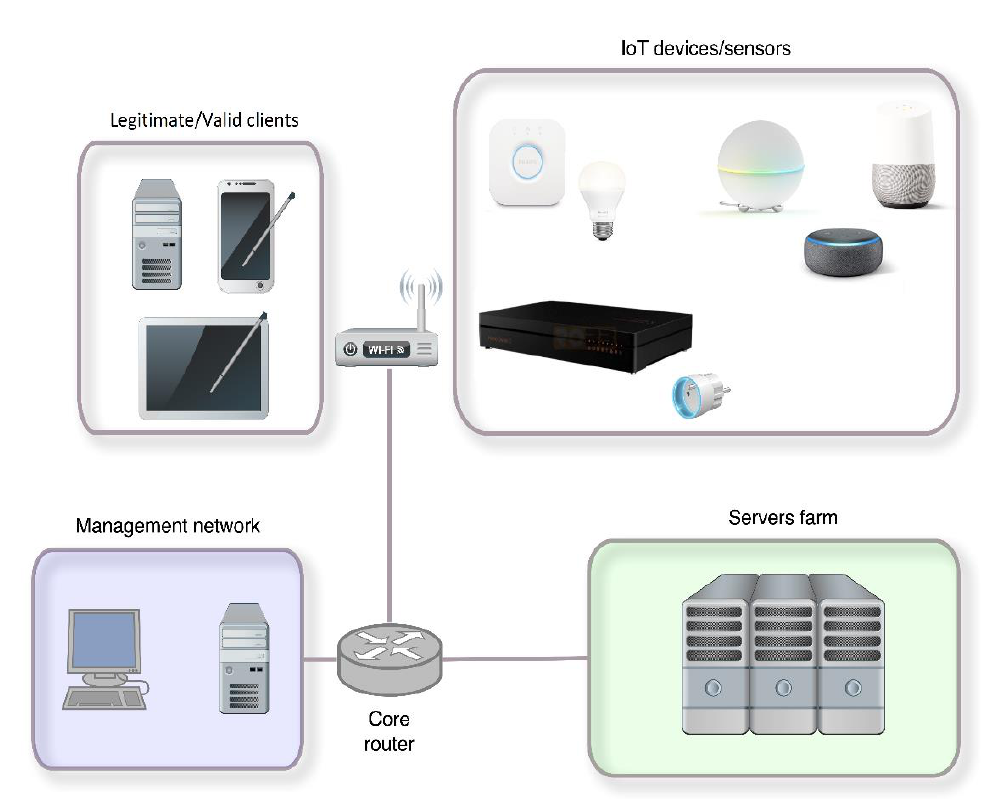
Figure 12. Structure of experimental environment.